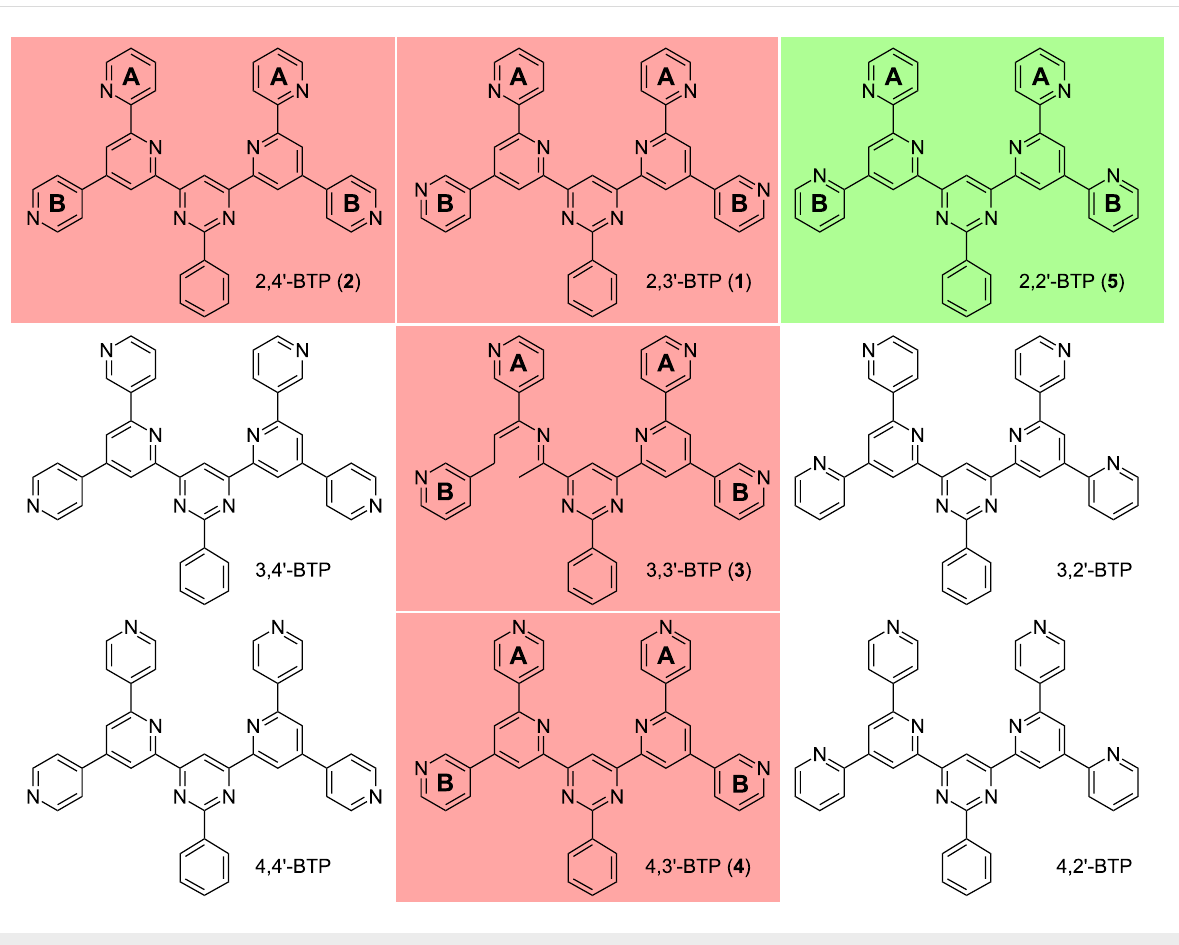
Figure 1: Nine possible constitutional BTP isomers with the four already described in literature (in red) [6,7] and the one newly synthesized as described in this paper (in